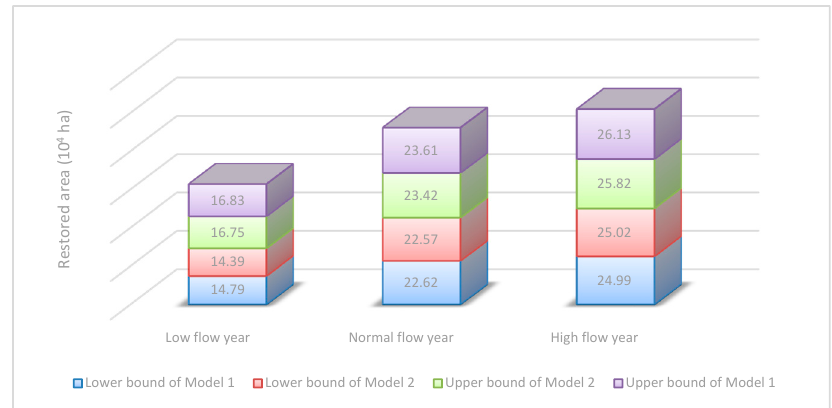
Figure 6. The comparison of the interval, double-sided, chance-constrained stochastic programming (IDCP) and IFDCP models from the perspective of the total water surface area.